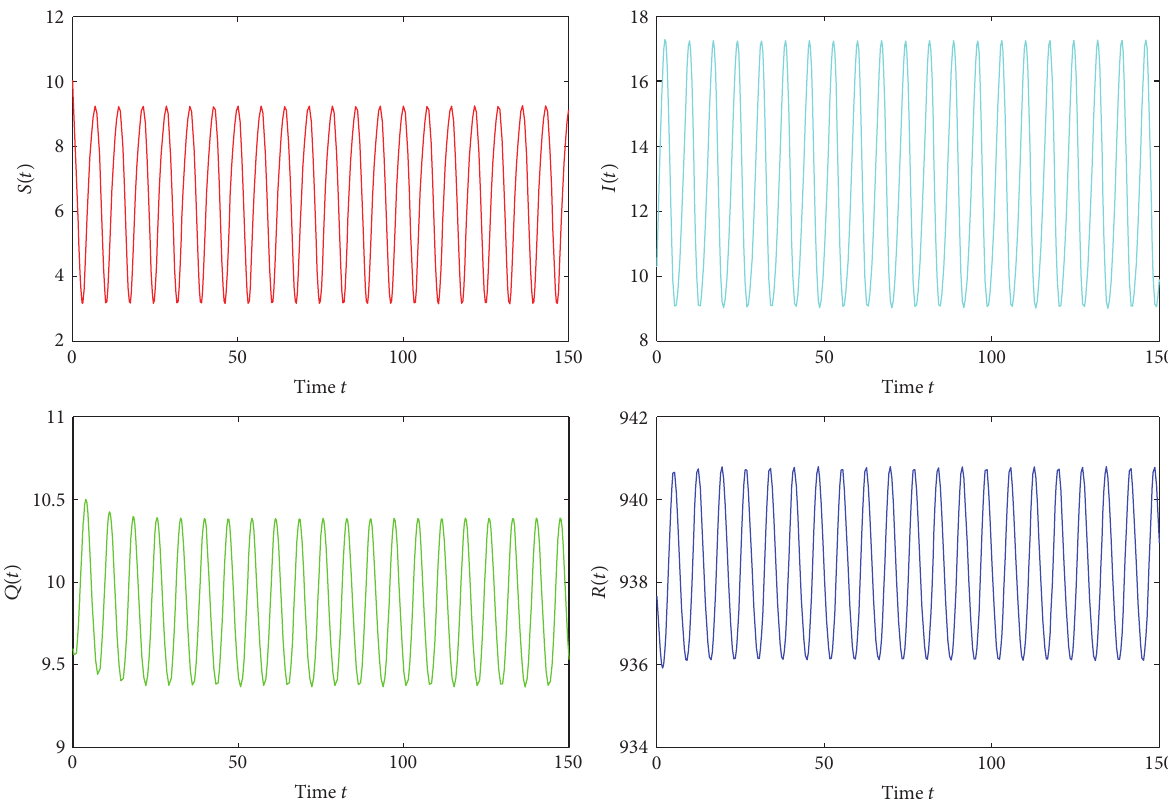
Figure 16: The trajectory of 𝑆 , 𝐼 , 𝑄 , and 𝑅 when 𝜏 1 = 0.9755 > 0.8903 = 𝜏 󸀠 10 and 𝜏 2 = 1.05 .